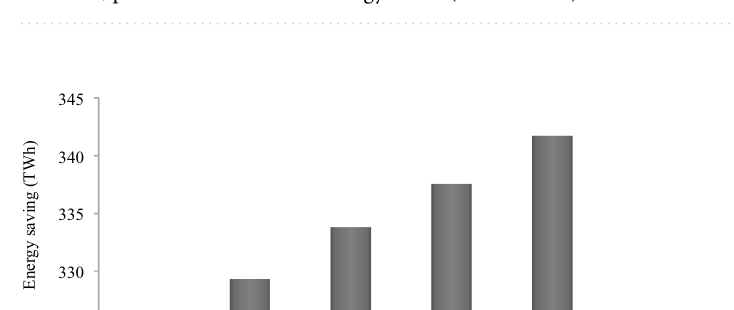
Table 7. Volume of water saved indirectly by reducing energy per capita use in the municipal water and domestic, public and commercial energy sector (cubic meters).